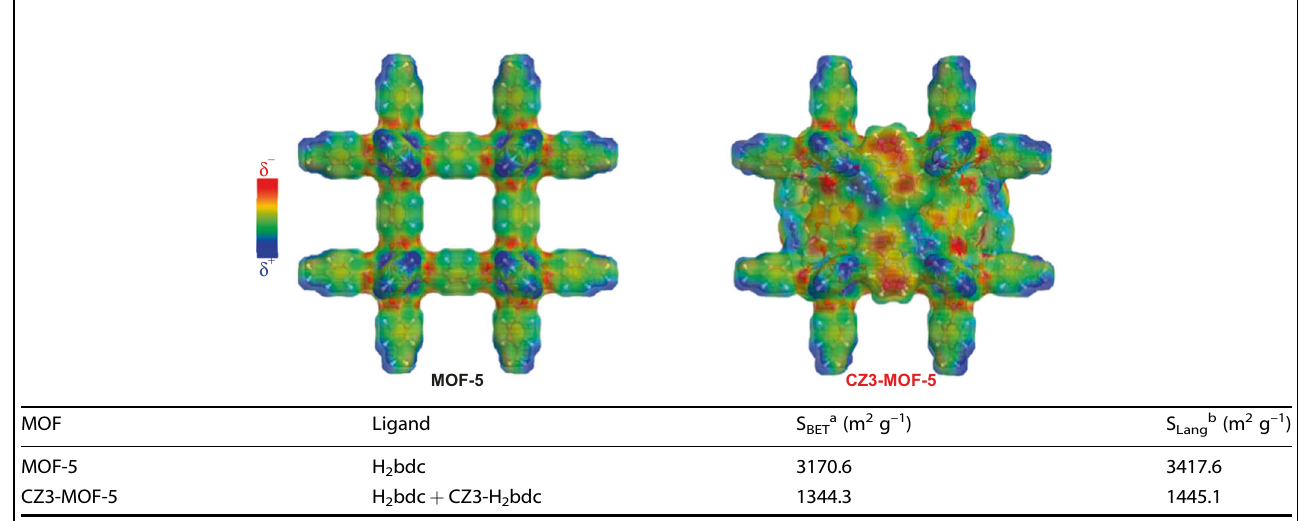
= BET surface area. b S a S BET